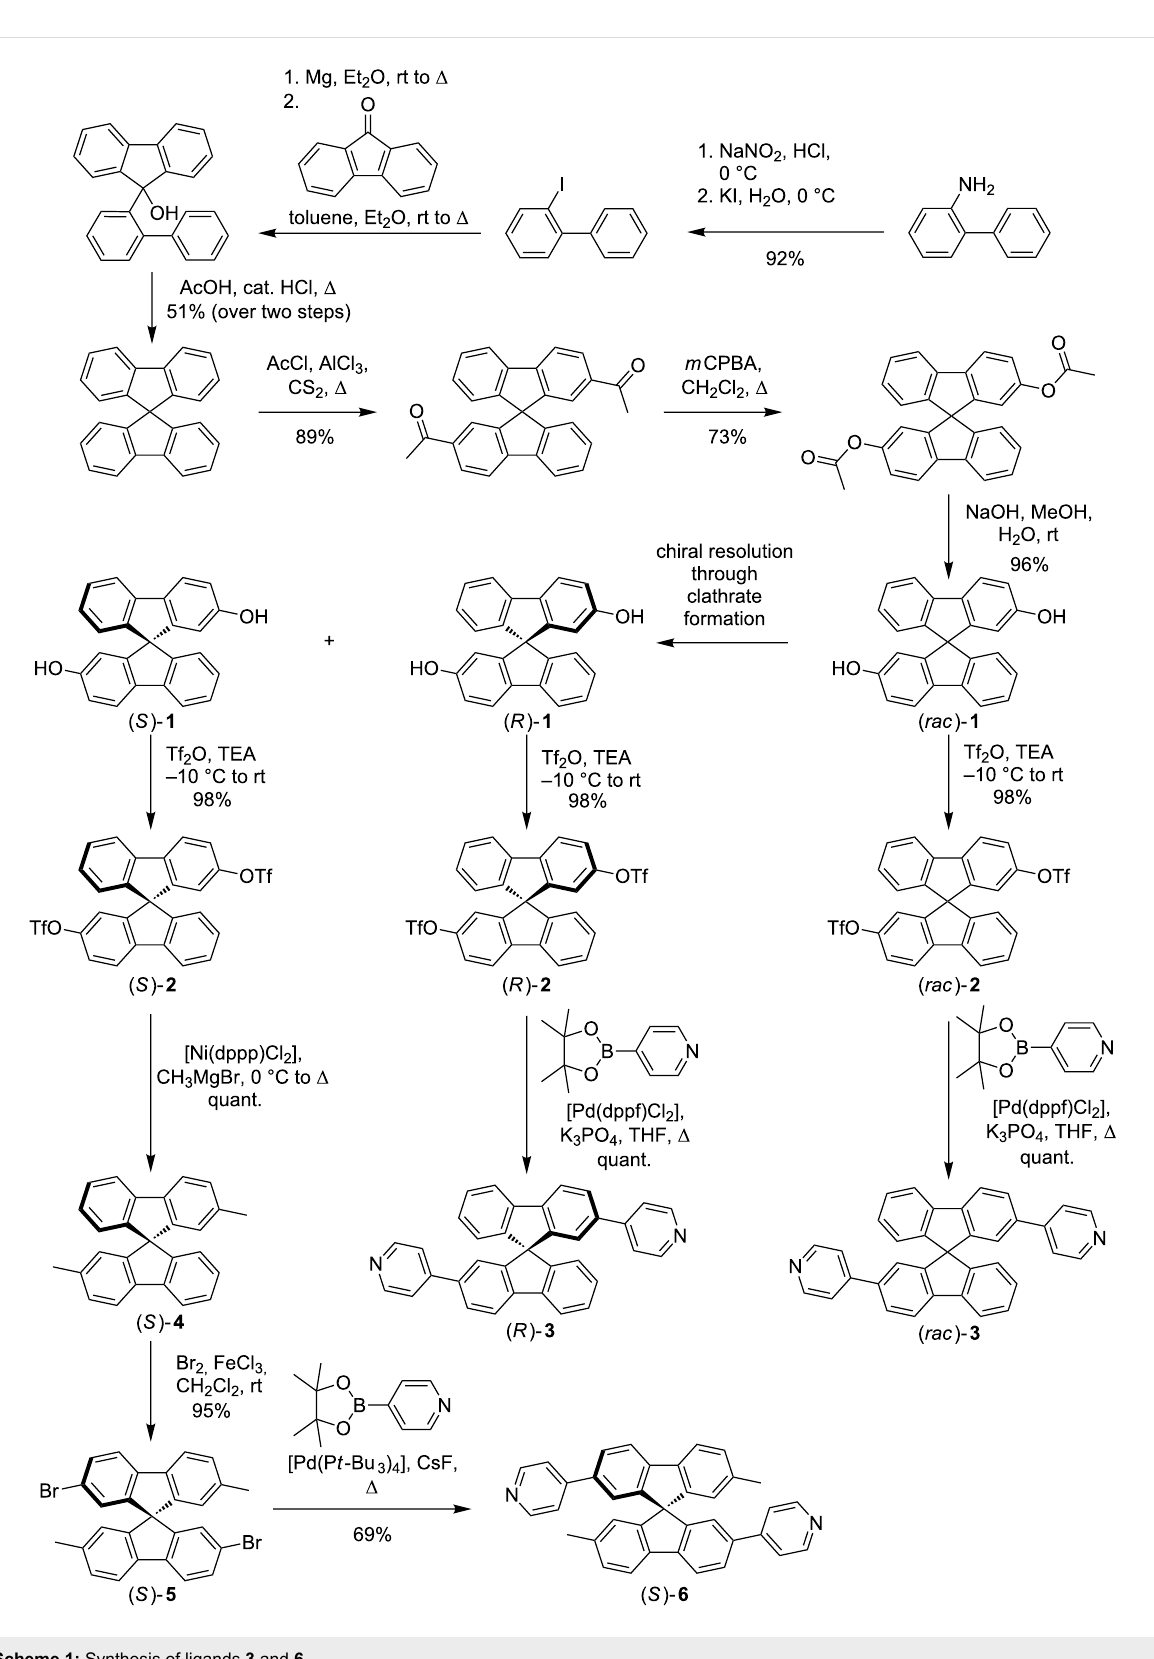
Scheme 1: Synthesis of ligands 3 and 6